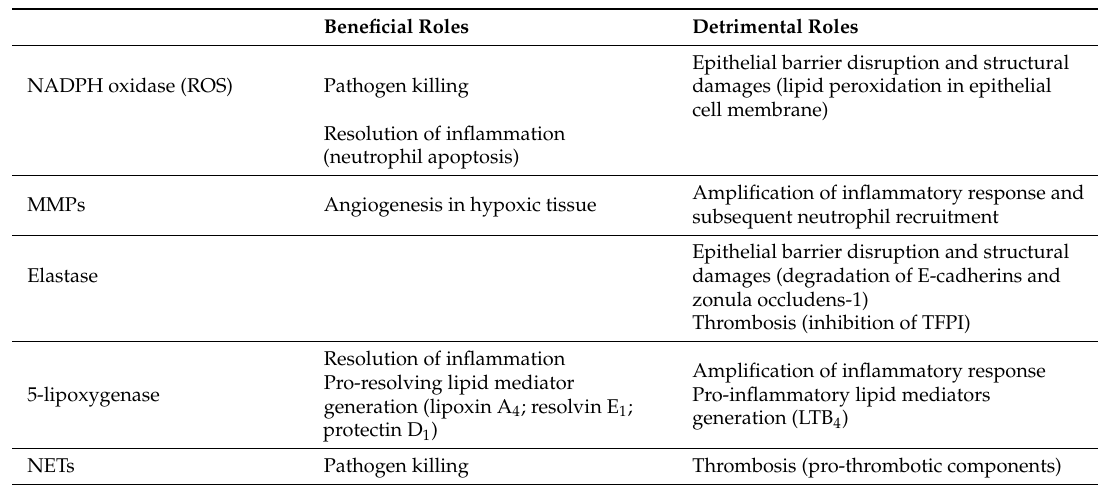
Table 1. Summary of beneficial and detrimental roles of factors brought by neutrophils in inflamed